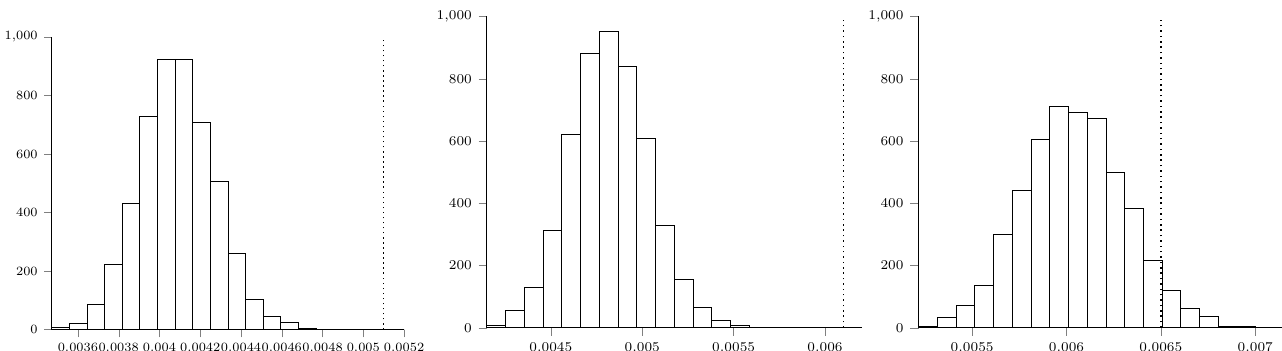
Figure A5. Histograms depicting the empirical null distribution, obtained via bootstrapping 5000 samples, of the MMD values (from left to right): MMD ( C , P ) ≈ 0.0051; MMD ( C , H ) ≈ 0.0061; and MMD ( P , H ) ≈ 0.0065. The corresponding true MMD values, that is, the ones we obtain by looking at the labels, are indicated as a dashed line in each histogram. We observe that these values are highly infrequent under the null distribution, indicating that the differences betwee the three classes are significant. Notably, the statistical distance between patients suffering from bacterial pneumonia and healthy patients (rightmost histogram) achieves a slightly lower empirical significance of ≈ 0.04. We speculate that this might be related to other pre-existing conditions in healthy patients that are not pertinent to this